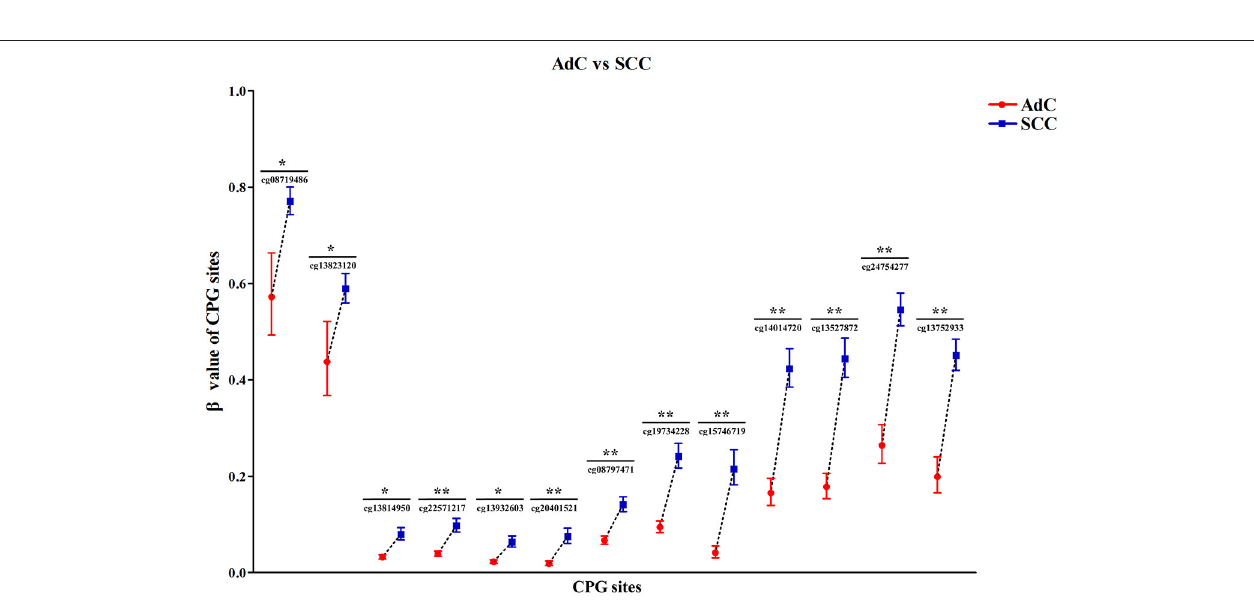
FIGURE 5 | Illustrative map for the associations of 13 CPG sites in DAPK1 promoter with CC risk, histological type of CC, FIGO stage of CC, HSIL risk, and DAPK1 mRNA expression in a pooled analysis of nine TCGA and GEO datasets.